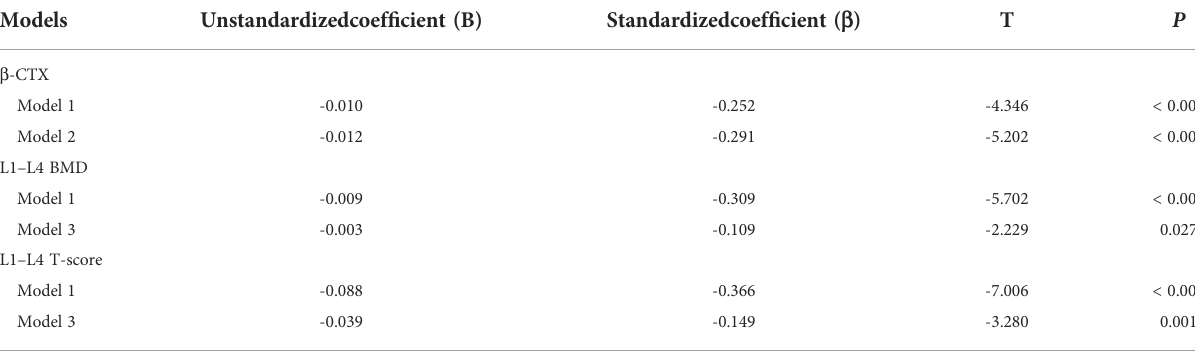
TABLE 4 Multivariate linear regression analysis of associations between PrFT and b -CTX, L1 – L4 BMD, and L1 – L4 T-score in postmenopausal women with T2DM. Models